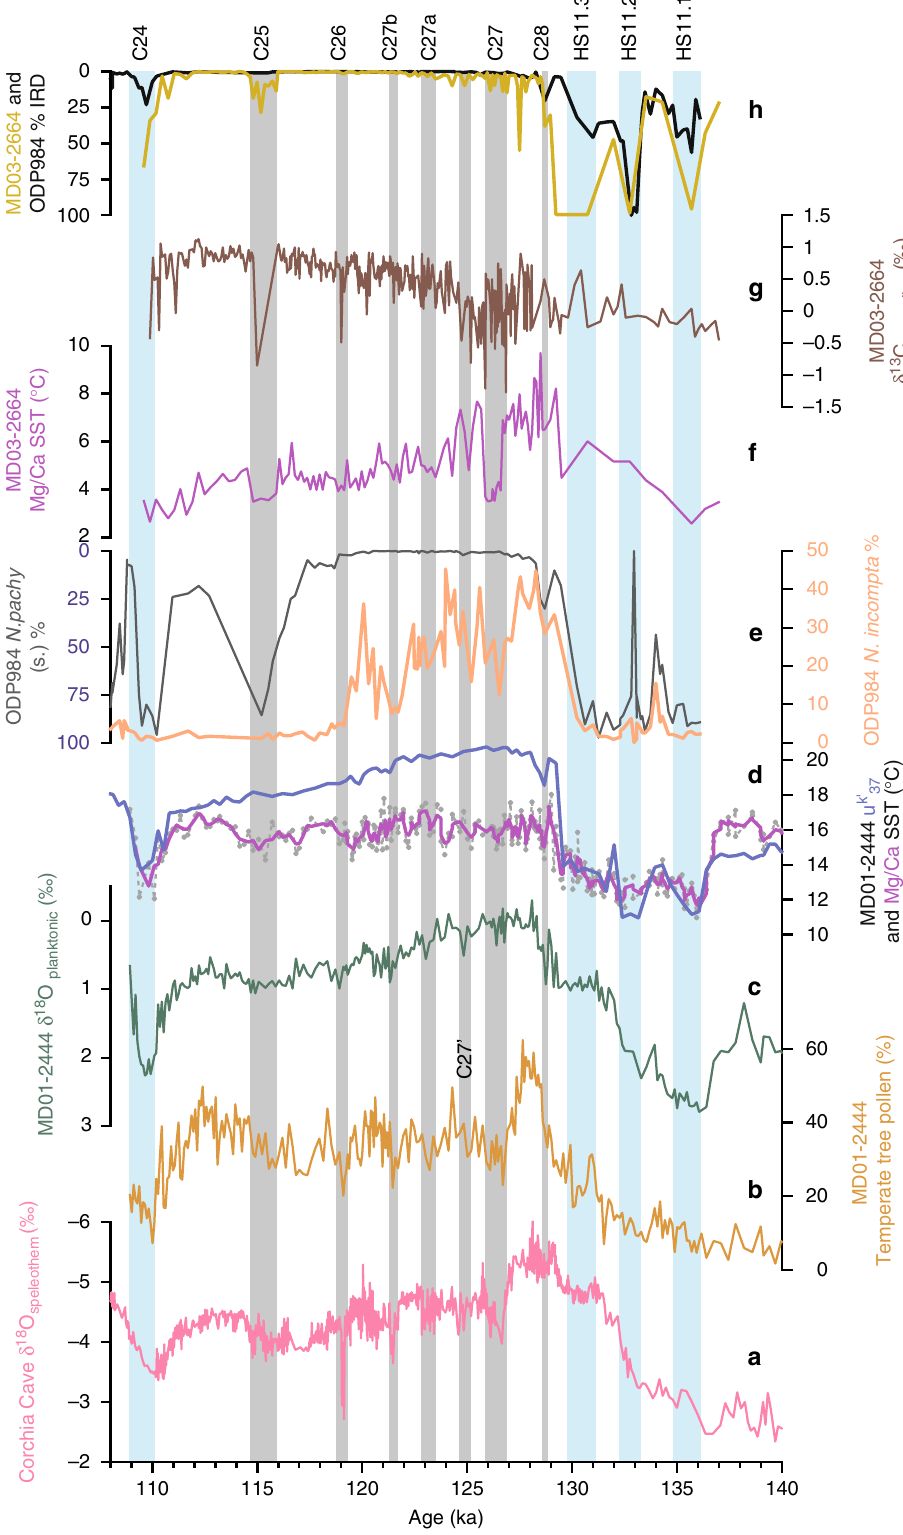
Fig. 3 Comparison of LIG paleoclimate records. a Corchia Cave stacked δ 18 O speleothem series. b – d MD01-2444 temperate tree pollen, δ 18 O planktonic , alkenone uk' 37 and Mg/Ca SST. e ODP984 Neogloboquadrina pachyderma (s) (inverse scale), N. incompta percentages 9 . f , g MD03-2664 Mg/Ca SST and δ 13 C 10, 39 ). h ODP984 (ref. 9 ) and MD03-2663 (ref. 39 ) IRD percentages. All records plotted on the Corchia Cave timescale (see Methods). C. wueller. (refs. Light blue vertical bars indicate events HS11.1, HS11.2, HS11.3 and C24; grey bars denote cold events C28, C27, C27a, C27b, C26 and C25 (refs. 6 – 9 ), and one identi fi ed on the Portuguese Margin, labelled C27